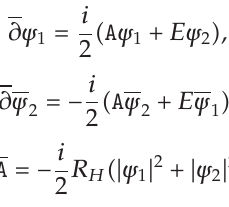
Figure 1: A numerical solution of (cid:7) 4.1 (cid:8) with E (cid:6) 5 (cid:7) in units adopted throughout the paper (cid:8) , R H (cid:6) 3 / 5, and A ≡ 0. The initial values ψ 2 prescribed on the edge facing front